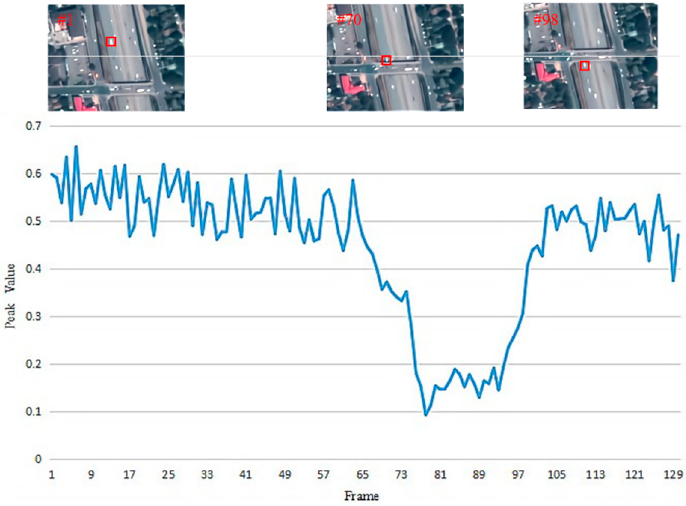
Figure 6. Visualisation of the tracking.